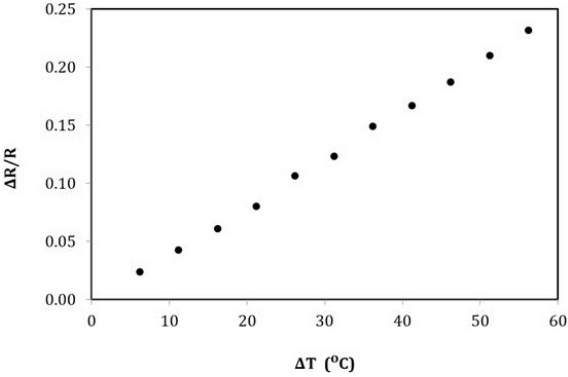
Figure 8. Temperature response showing the change in resistance with respect to change in temperature for a resistive sensor in a sen- sor